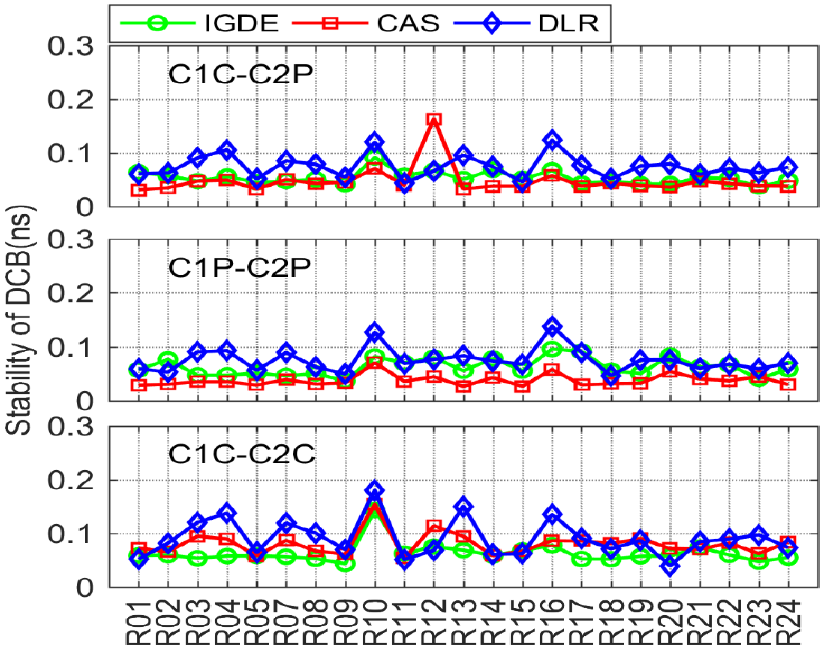
Figure 12. Stability of the GPS DCB obtained by IGDE, CAS, DLR, and CODE.